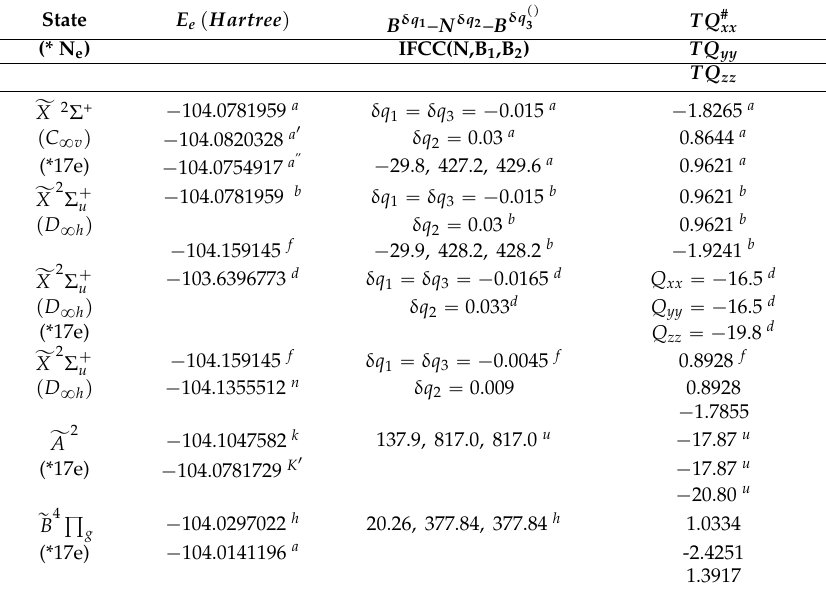
Table 4. { TQ # : Traceless Quadrupole moment (Debye-Ang)}; ( § ) Charges from ESP fitting and Isotropic Fermi Contact Couplings (MHz)